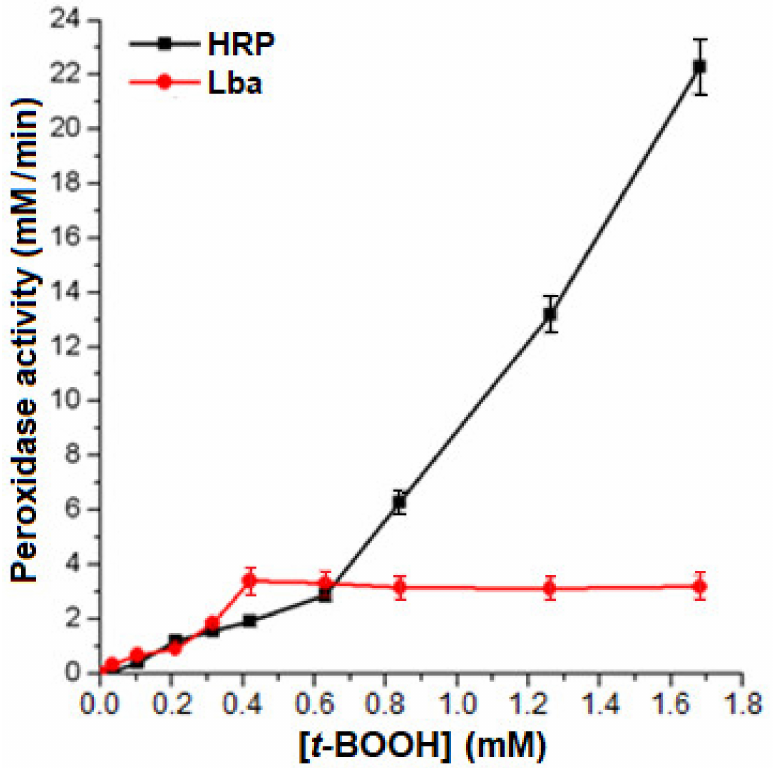
Figure 6. The dependence of initial rate of the peroxidase reaction catalyzed by Lb a and by horseradish root peroxidase (HRP) on the concentration of t -BOOH. Peroxidase activity was measured in the presence of 8 µ M Lb or 0.8 µ M HRP and 0.8 mM o